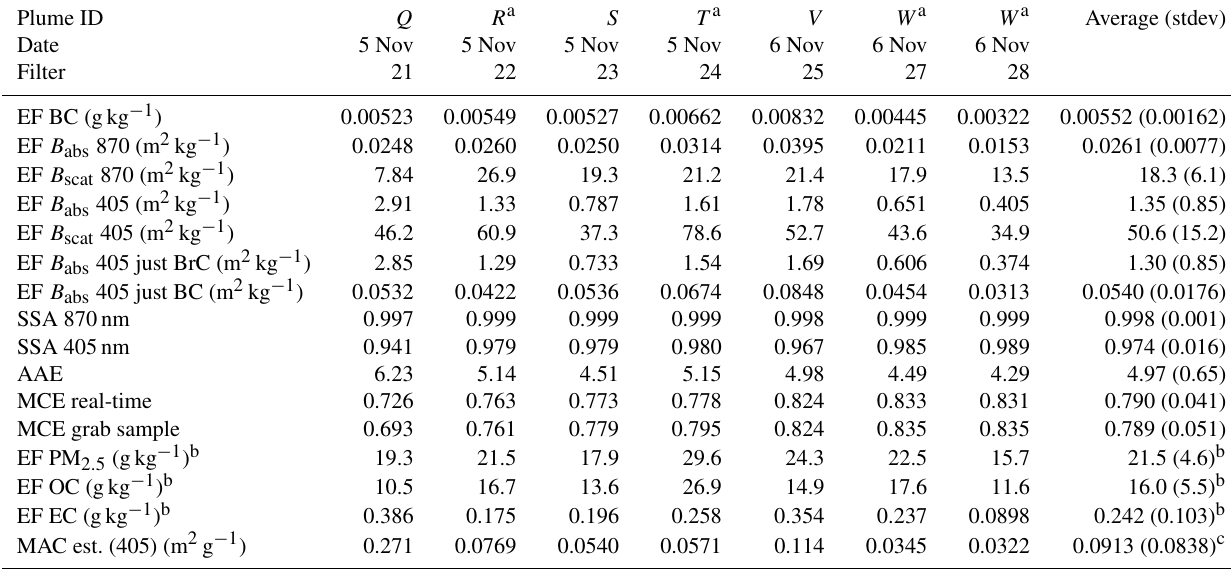
Table 2. Aerosol emission factors and optical properties measured by the PAX and filter sampling. Plume